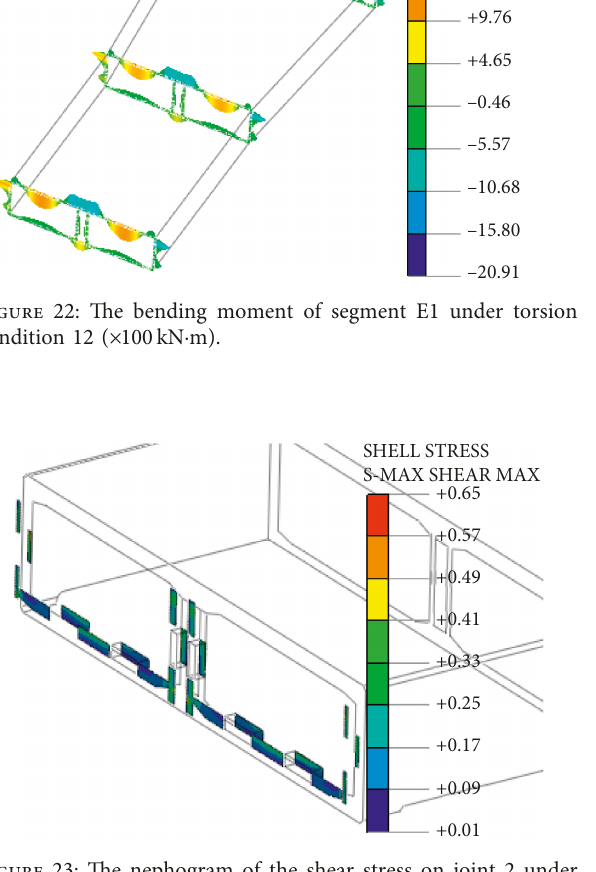
Figure 23: The nephogram of the shear stress on joint 2 under working condition 12.